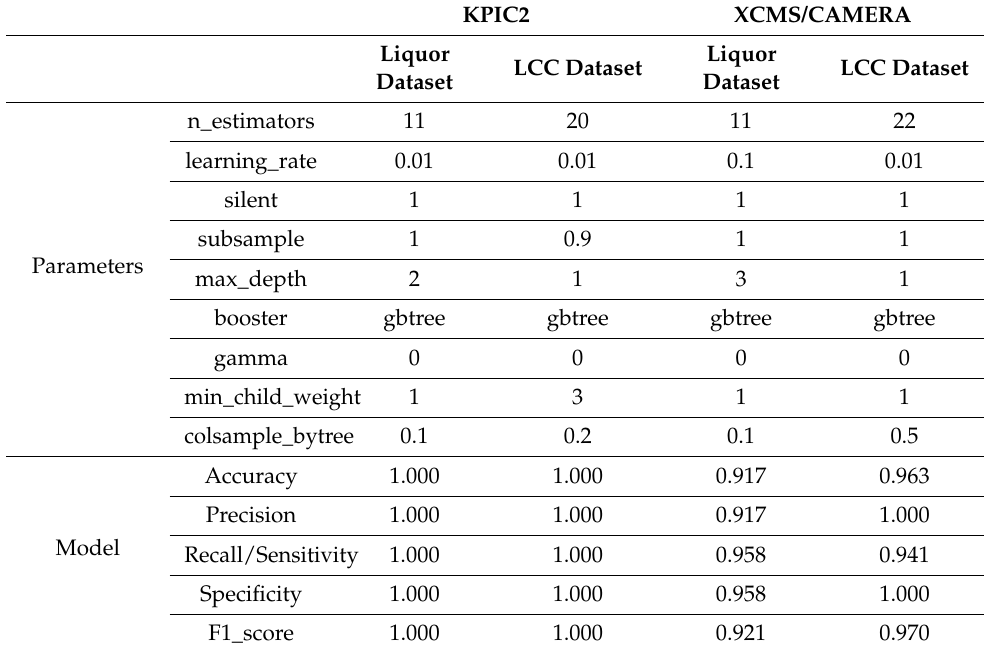
Table 1. The parameters of optimized models and their evaluation criteria on the test sets.